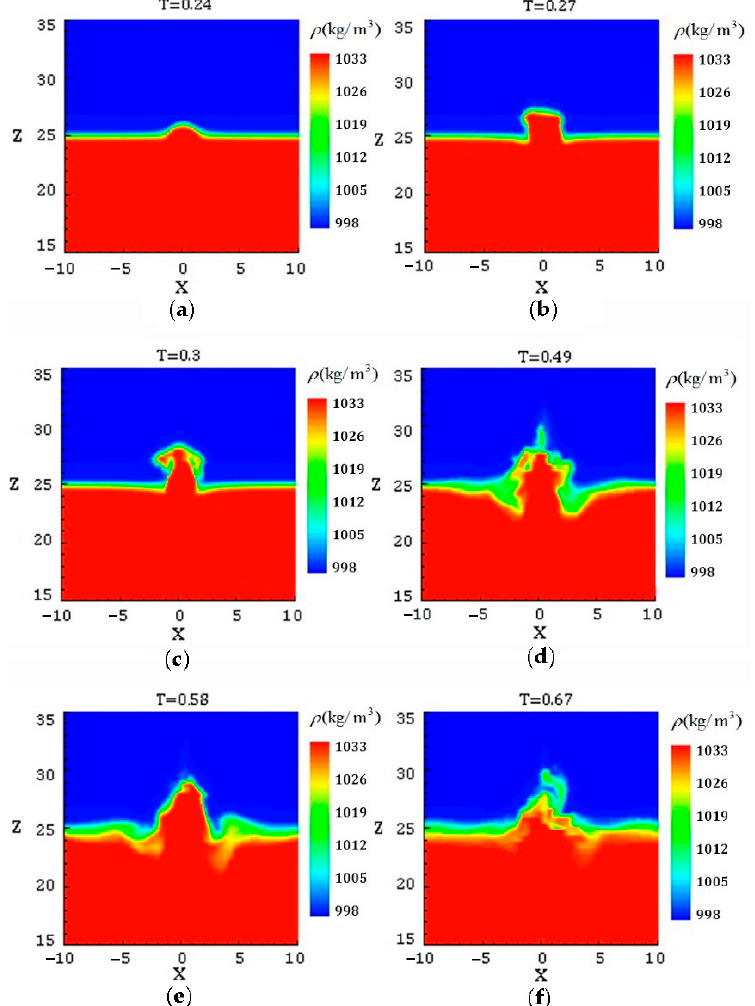
Figure 12. Instantaneous density contours at the plane of Y = 0 during the jet impinging on the pycnocline in case A3. ( a )~( f ) corresponding to T = 0.24~0.67.